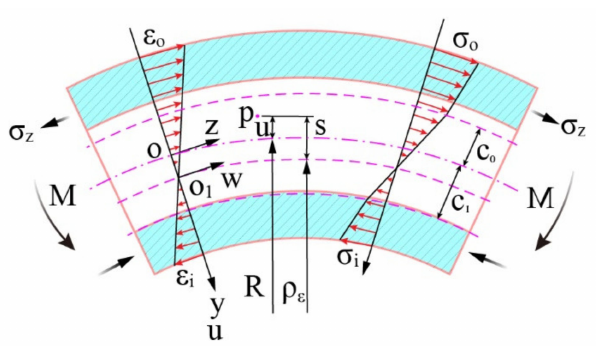
Figure 3. Fully elastic deformation stage.